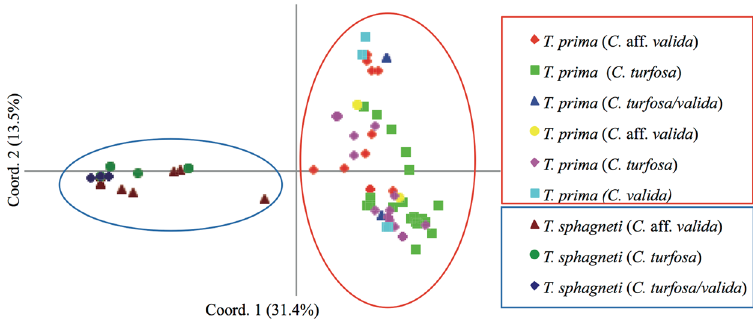
328.26 2.05 100% Table 3. Hierarchical AMOVA for four loci amplified for Tulasnella prima and Tulasnella sphagneti .